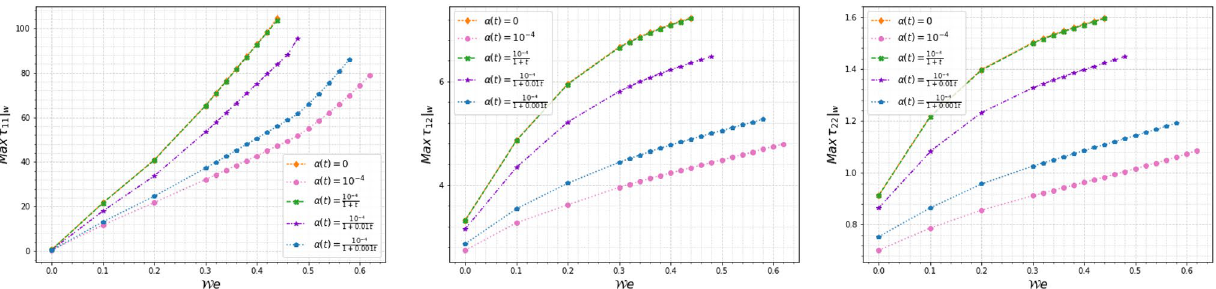
Fig. 7 Maximum values of the extra stress tensor components along the channel wall for different setting of parameter 𝜀 in the diffusion coefficient 𝛼 ( t ) = 10 − 4 , depending on the Weissenberg number W e 1 + 𝜀 t